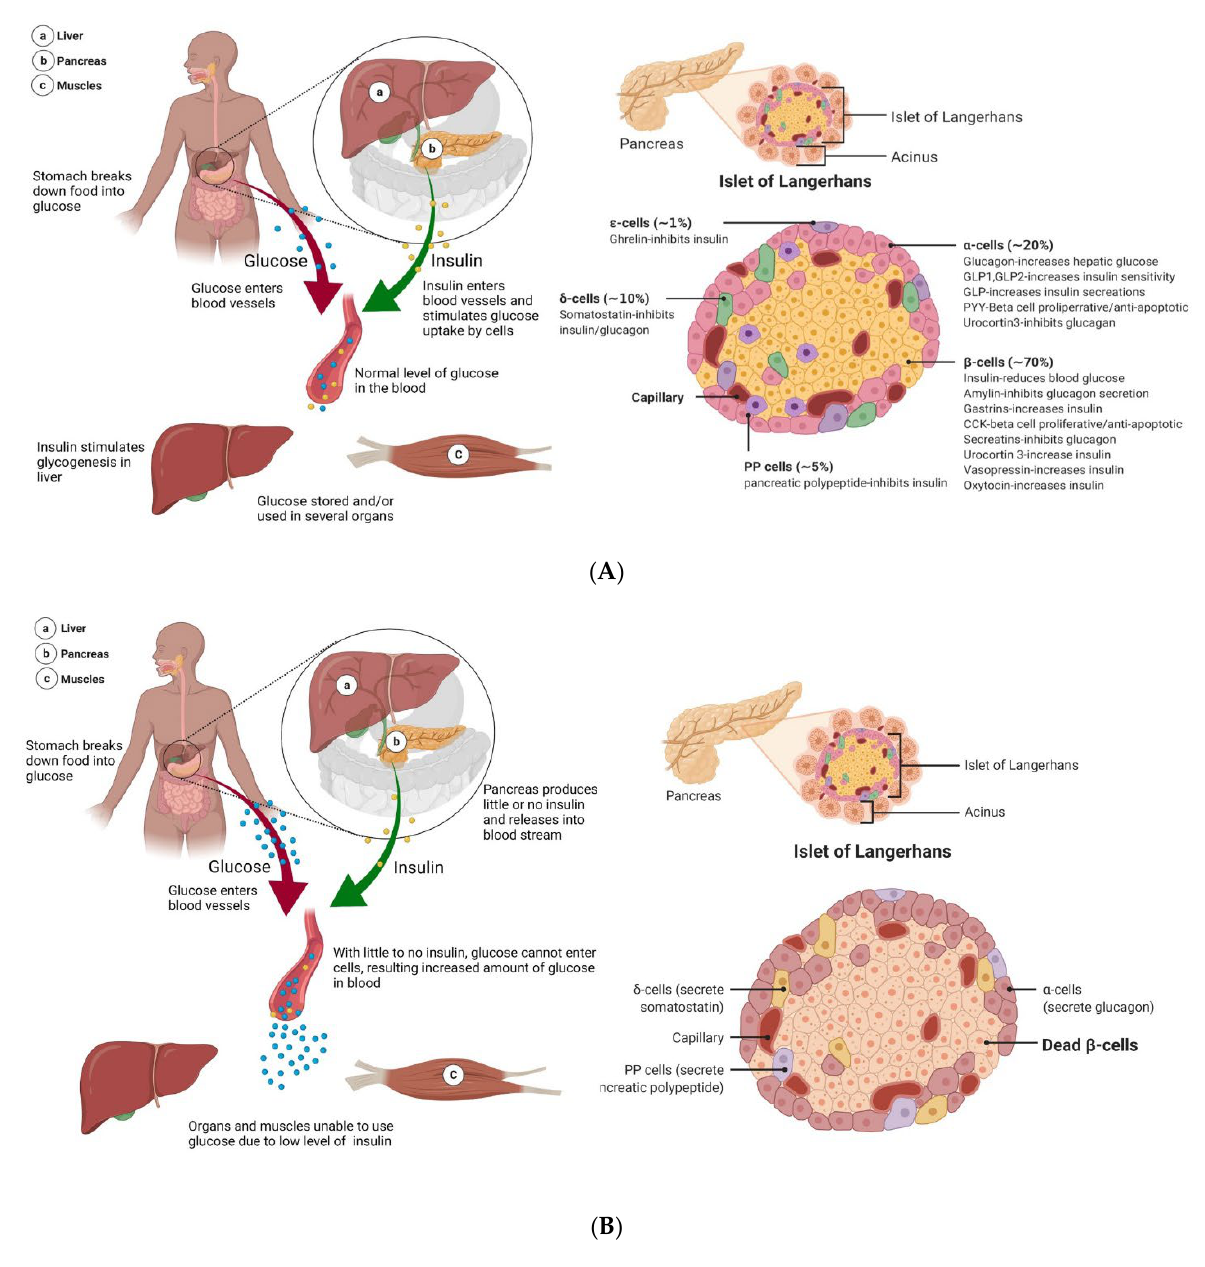
Figure 2. Processing of glucose in healthy and T1DM patients. ( A ) As food is ingested in a healthy system, it gets broken down into glucose, which is then released into the bloodstream. In response, the pancreas secretes insulin. Glucose is transported across the membrane via facilitated diffusion. As such, as insulin increases the glucose permeability of cells, this allows the uptake and utilization of glucose. The pancreas is made up of many important cell structures, including the islets of Langerhans. The islets are a low percentage of the total pancreas mass but include cells that are vital in glucose regulation. This includes β -cells, the primary component of islets, making up 65–80% of the total islet cell count. β -cells are responsible for the production and secretion of insulin and amylin. ( B ) In diabetic patients, as food is digested and converted into glucose to be released into the bloodstream, the normal corresponding insulin response is lacking. This is because the pancreas is no longer producing enough insulin to enable the uptake and utilization of glucose, leading to a state of hyperglycemia. In T1DM, a large number of β -cells in the pancreas are killed due to autoimmune instigated T-cell attacks. Though some β -cells may remain, the pancreas is no longer capable of insulin independence.